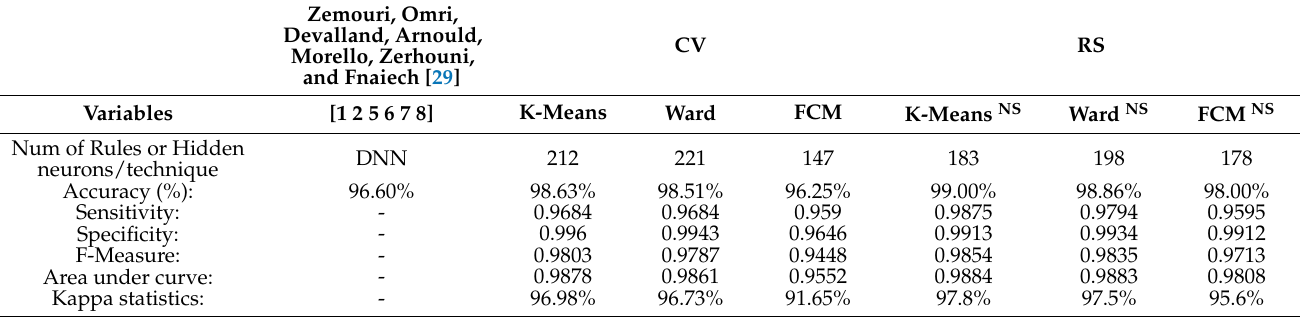
Table 5. Performance metrics obtained with our proposed framework compared with results obtained by Zemouri, Omri, Devalland, Arnould, Morello, Zerhouni, and Fnaiech [29]. Zemouri, Omri, Devalland,